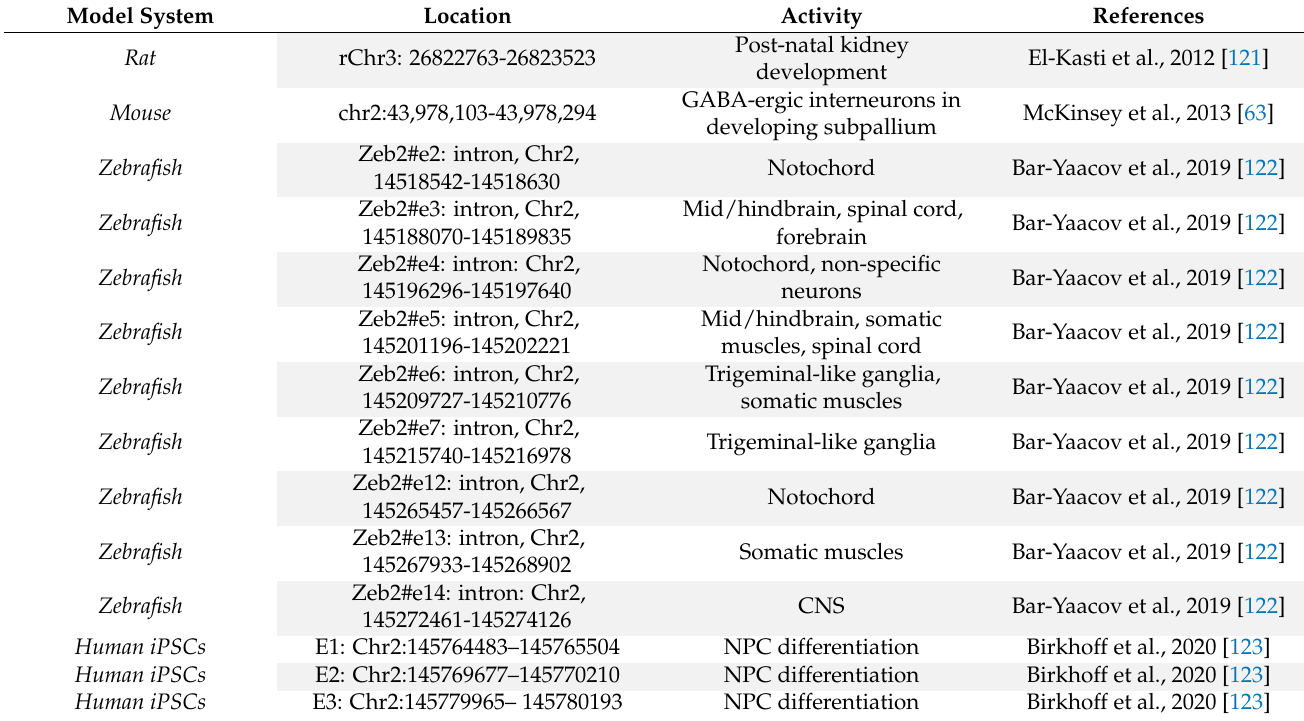
Table 2. Identified ZEB2